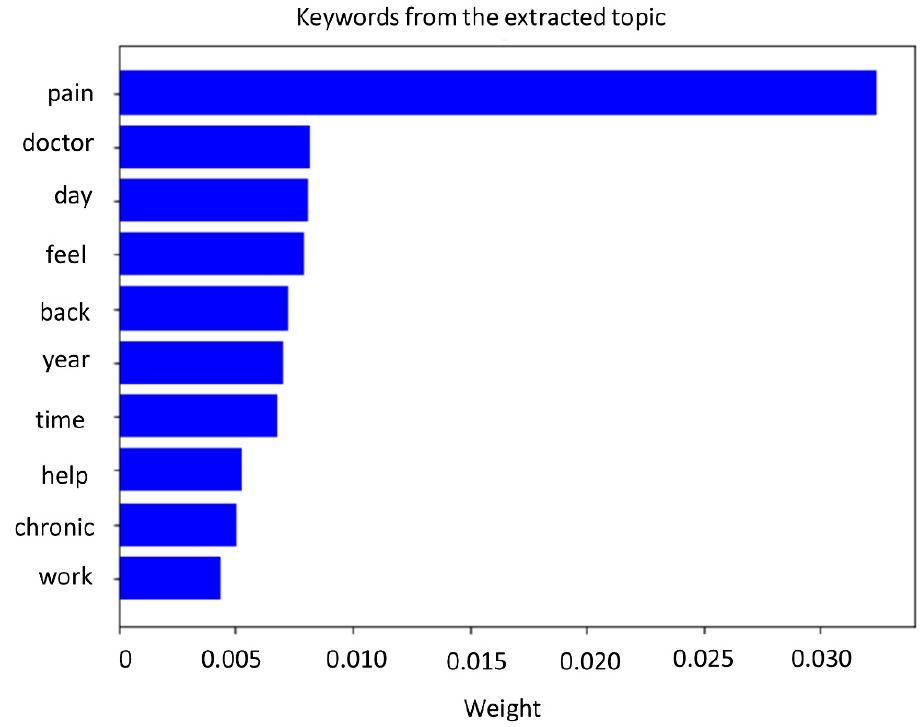
Figure 4. Keywords with corresponding weights that contribute to the selected topic, based on topic modelling with latent Dirichlet allocation.